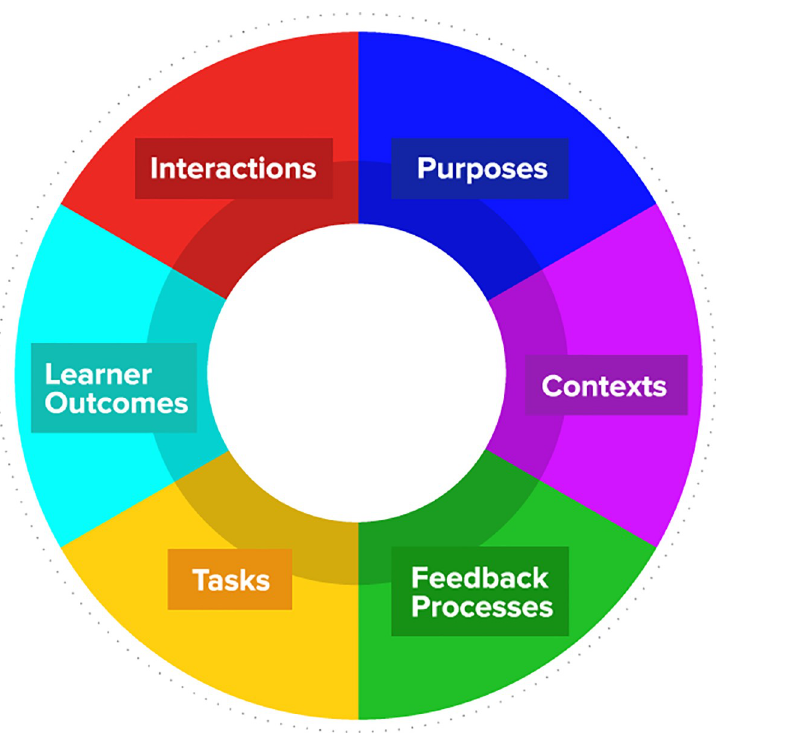
Fig 1. Assessment Design Decision